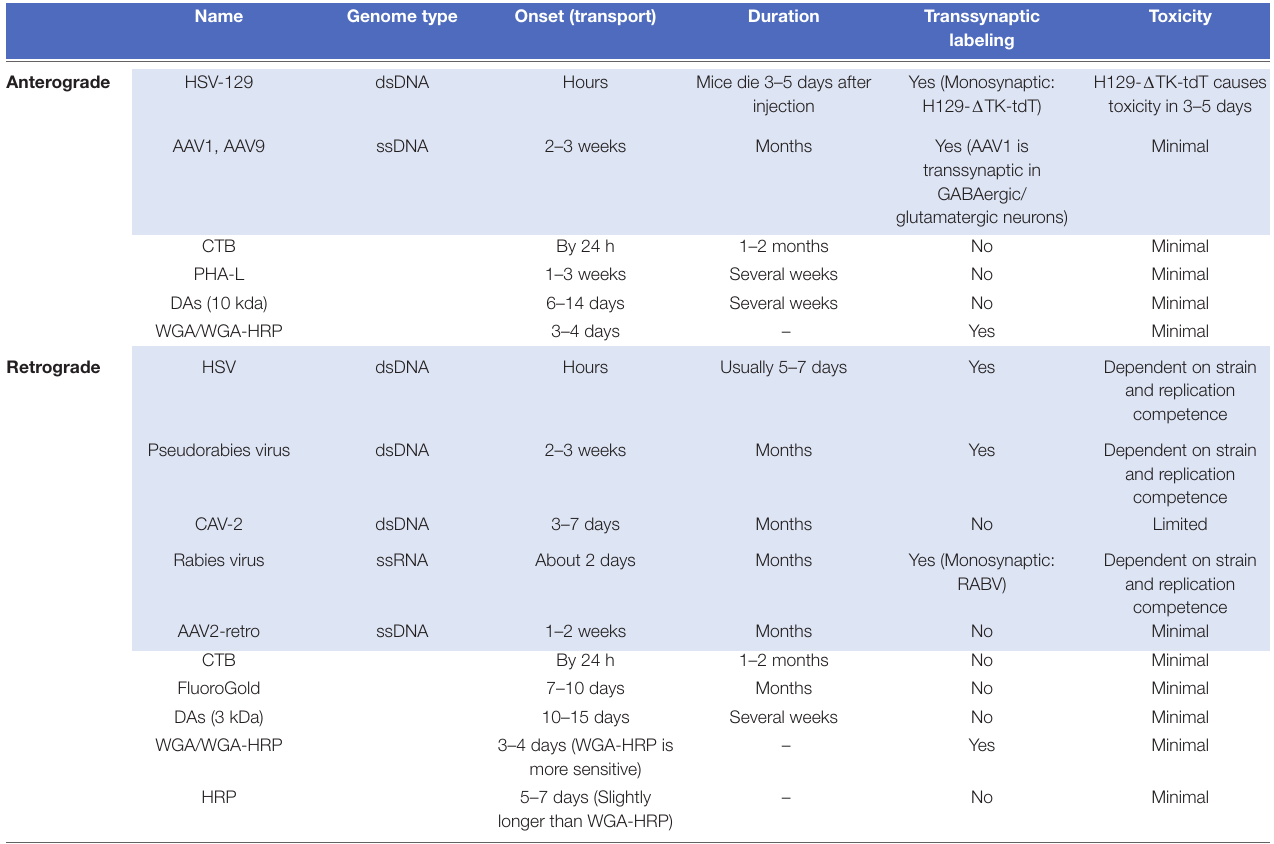
TABLE 1 | Properties of commonly used conventional (white) and viral neural tracers (blue).